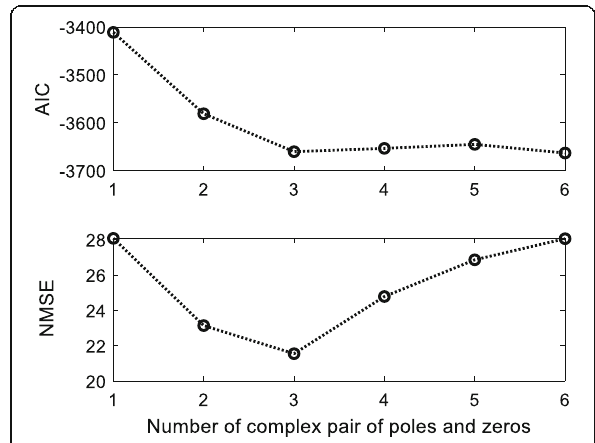
Fig. 8 AIC score and NMSE between original and predicted (a posteriori) time series for an increasing number of complex pair of poles and zeros. The smallest AIC and NMSE value was achieved for three complex poles and three complex